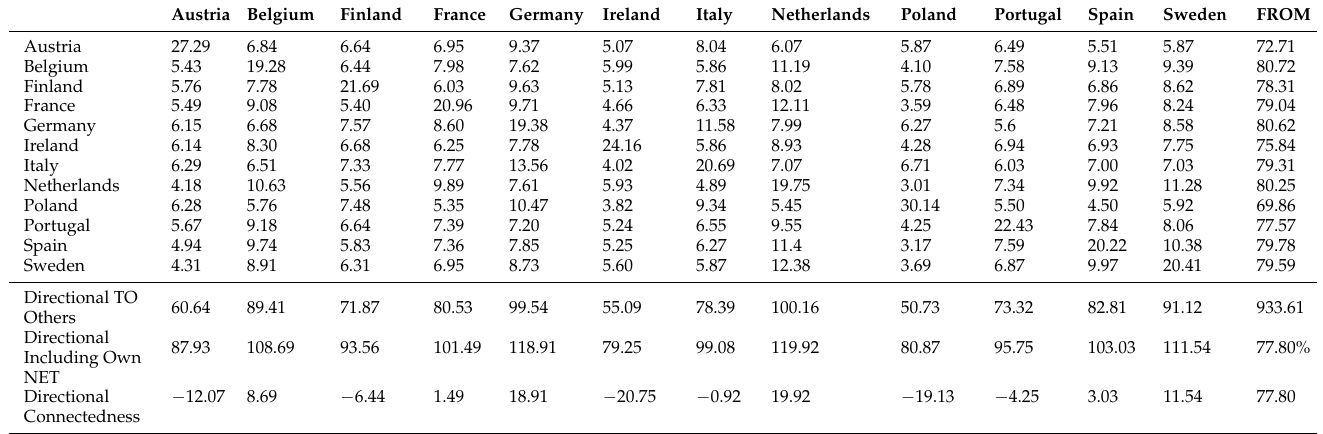
Table 4. Intraday Volatility Spillover among 12 European Stock